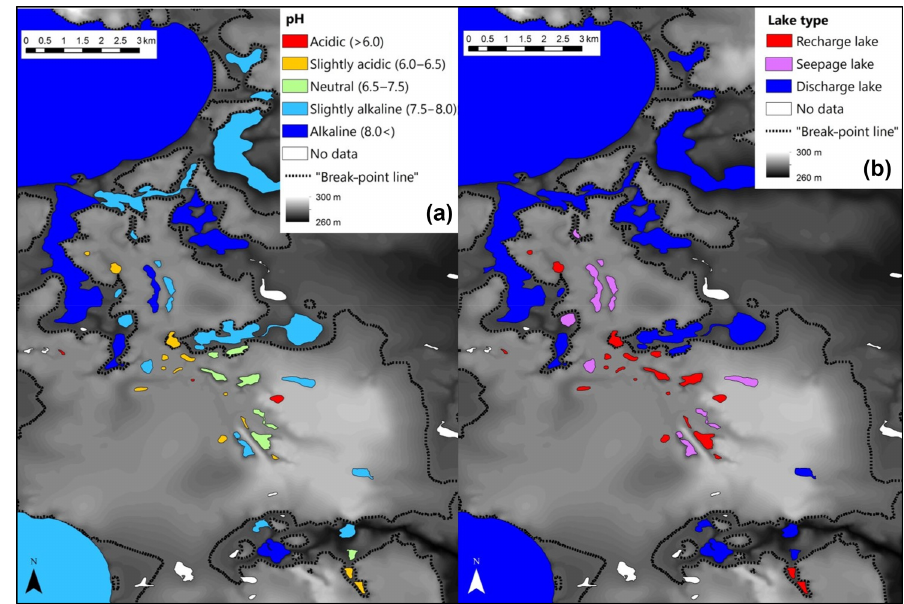
Figure A1. Spatial depiction between elevation and lake-water pH (a) and lake type (b) . The elevation of the breakpoint line (284m) is shown as a dashed line.